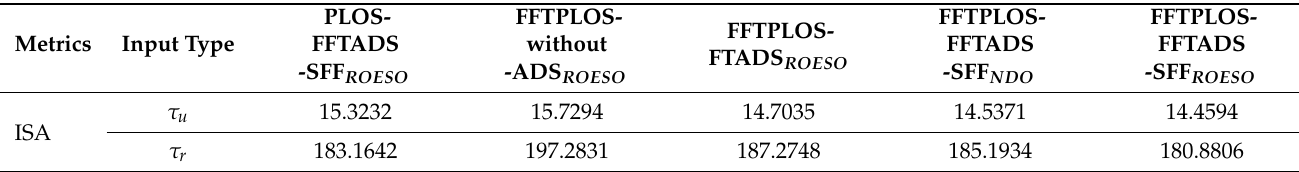
Figure 9. The control inputs. Table 4. ISA performance comparisons of different